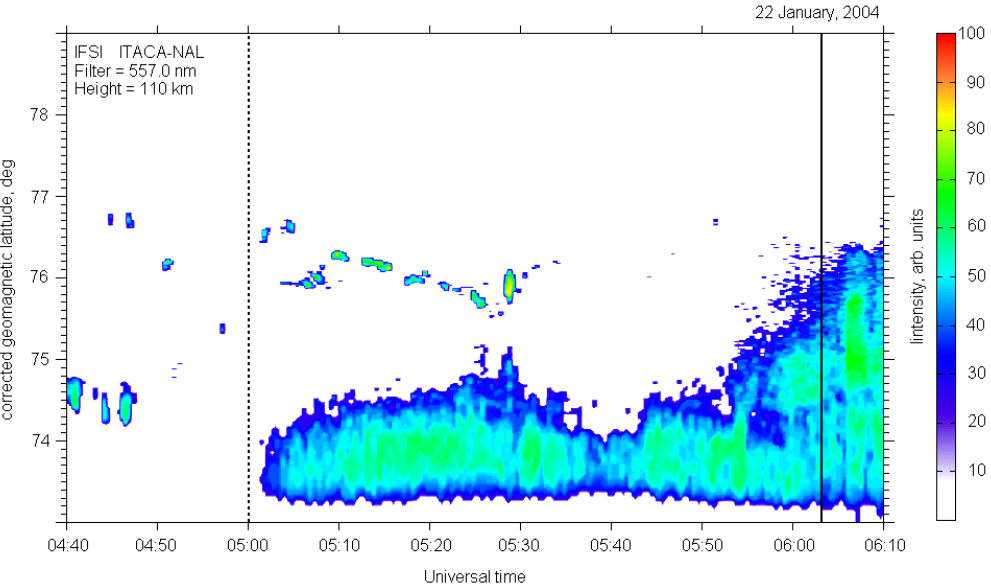
Fig. 4. Auroral activity above Spitsbergen as seen by ASC camera in Ny ˚Alesund. Dashed line indicate the substorm onset, bold line at Auroral activity above Spitsbergen as seen by ASC camera in Ny Ålesund. Dashed 06:03 UT refers to the moment of torch line indicate the substorm onset, bold line refers to the moment of torch appearance.